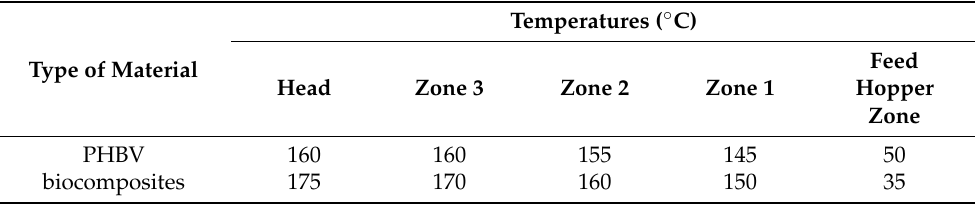
Table 2. The heating zone temperatures of a single screw extruder.